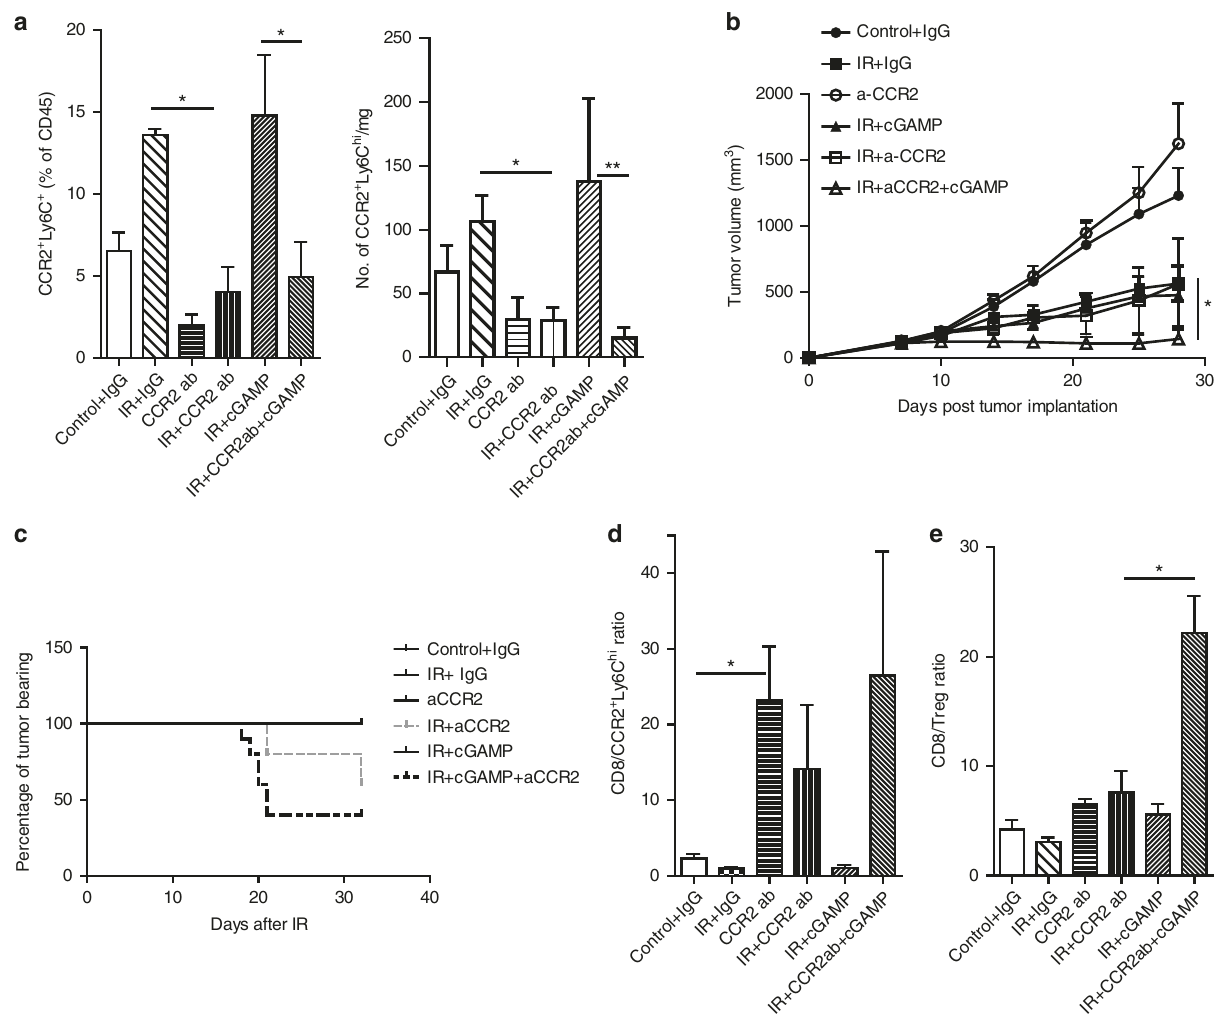
Fig. 6 MDSC depletion enhances tumor response to radiation and STING agonist cGAMP treatment. a Flow cytometry analysis of immune CCR2 + Ly6c hi cells 3 days after IR ( n = 3). b Tumor growth curves; n = 6; c percentage of tumor bearing mice ending on 33 days after starting of the treatments. d , e ratios of percentage of CD8 over CCR2 + Ly6c hi and Treg cells in treated tumors, respectively. n = 3. * P < 0.05; ** P < 0.01. The experiments were repeated three times. Data are presented as mean ±